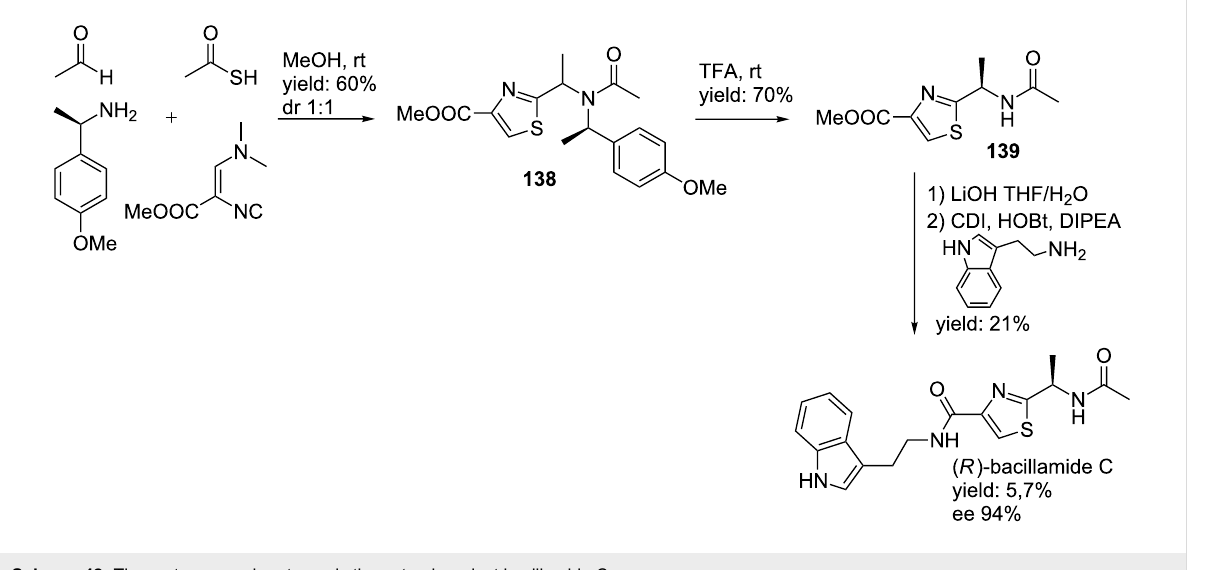
Scheme 42: Three-step procedure towards the natural product bacillamide